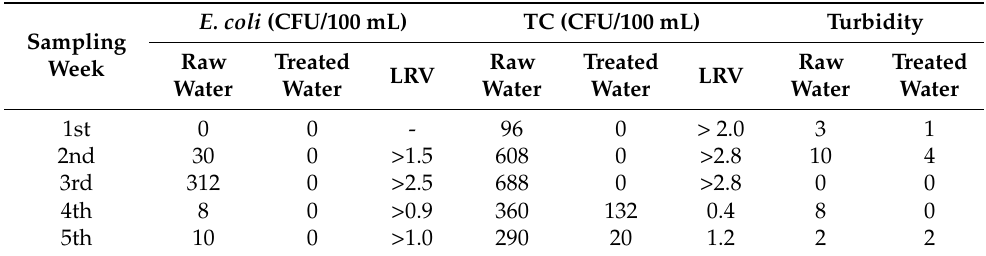
Table 4. Concentration of E. coli and TC and LRV in RO + UV